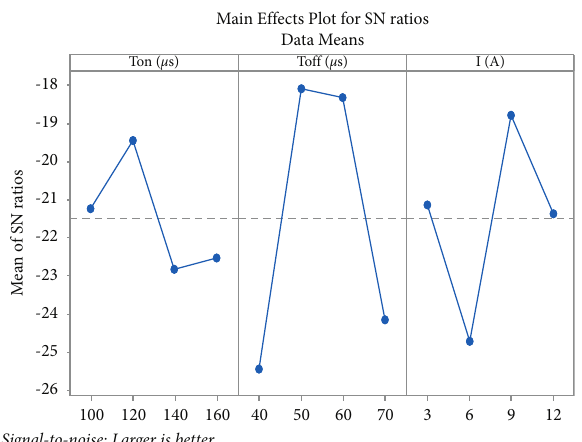
Figure 2: Means of SN ratio for MRR.